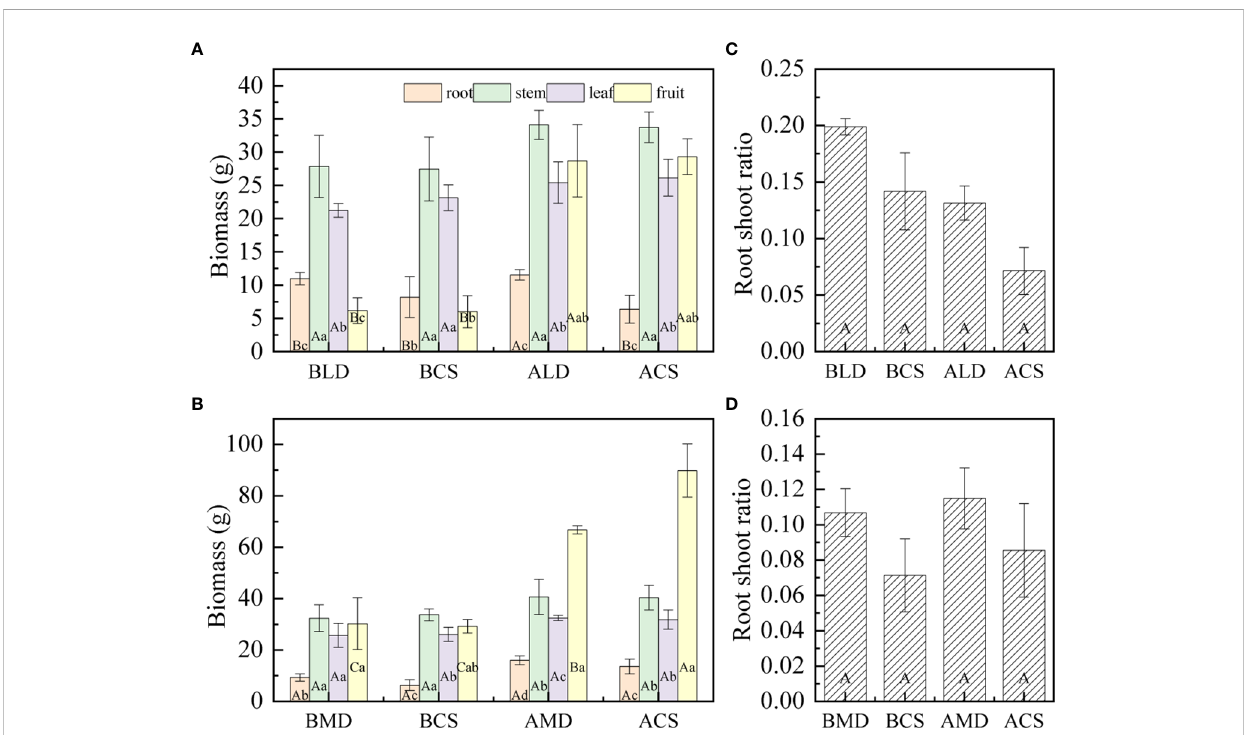
FIGURE 6 Comparative analysis of biomass and root shoot ratio of component organs in different drought and after rehydration. (A, B) are the comparison of biomass of each component organ of LD and MD, respectively; (C, D) are the comparison of root shoot ratio of organs in LD and MD, respectively. Error bars represent standard deviations (n =3), different capital letters indicate signi fi cant difference between groups (p<0.05), and different lowercase letters indicate signi fi cant difference between different organs in the same group (p<0.05). Note: BLD, BCS, ALD, and ACS and BMD, BCS AMD, and ACS have the same de fi nitions as in Figure 3.